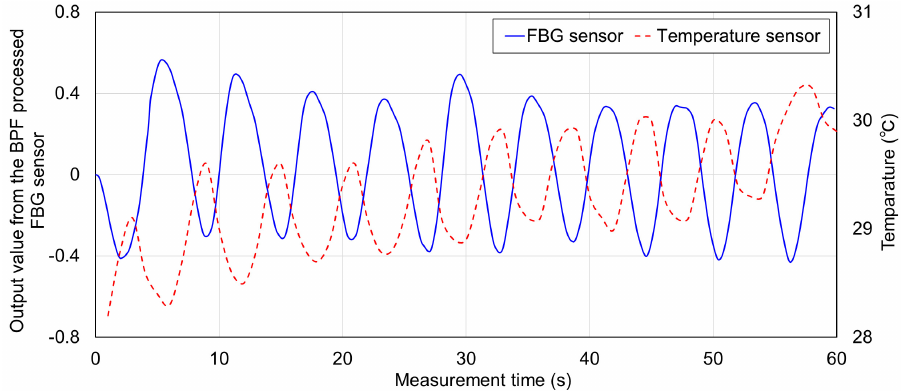
Figure 7. Signals measured by the FBG sensor and the temperature sensor.